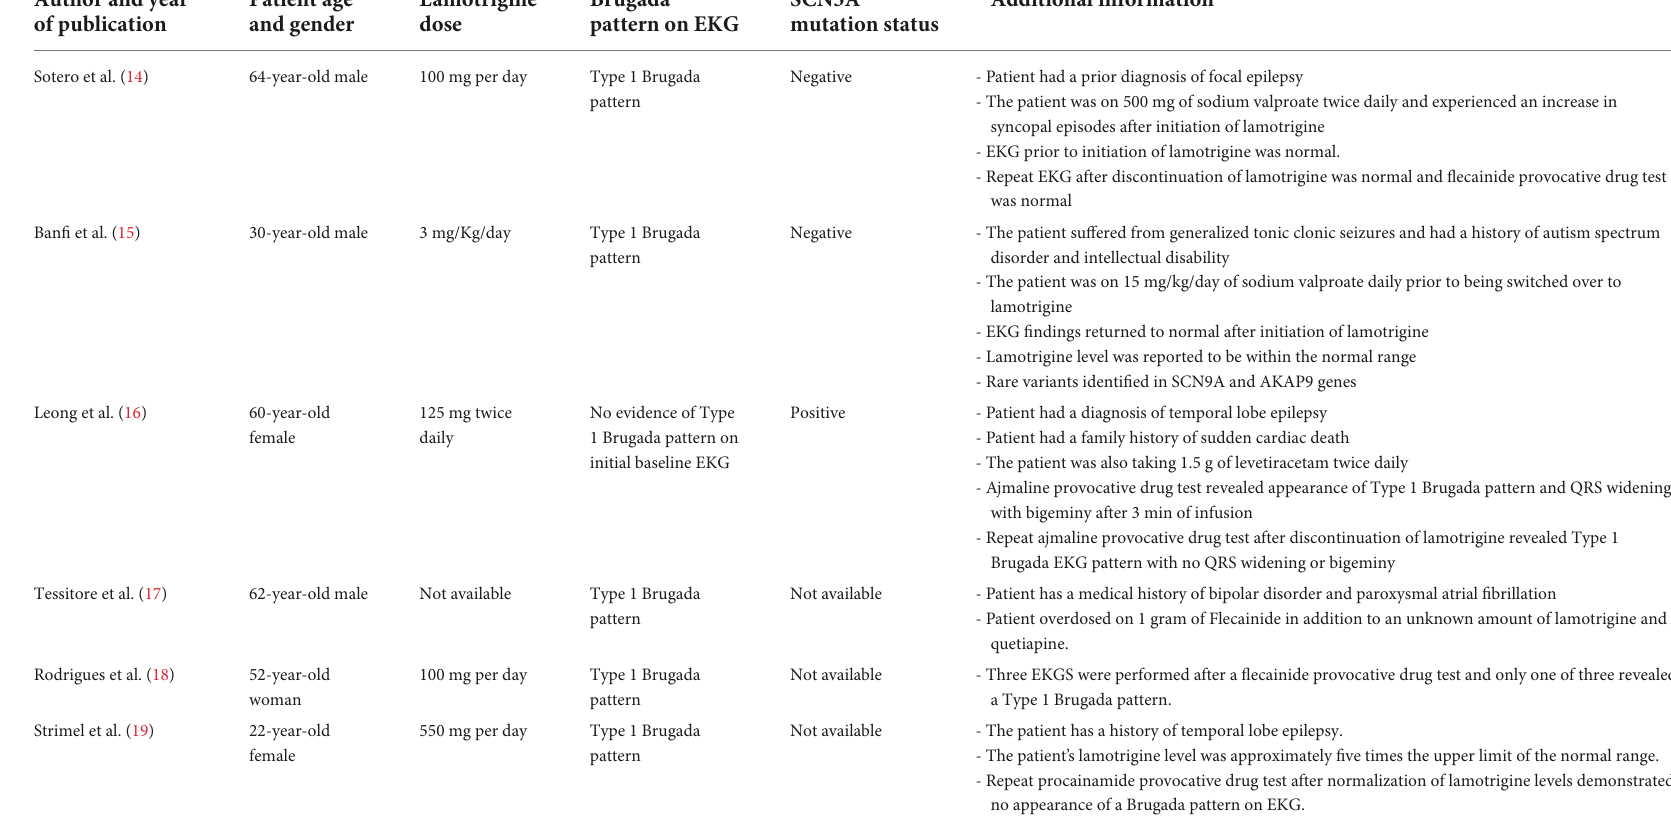
TABLE 2 Characteristic features of six publications reporting the association between lamotrigine therapy and Brugada